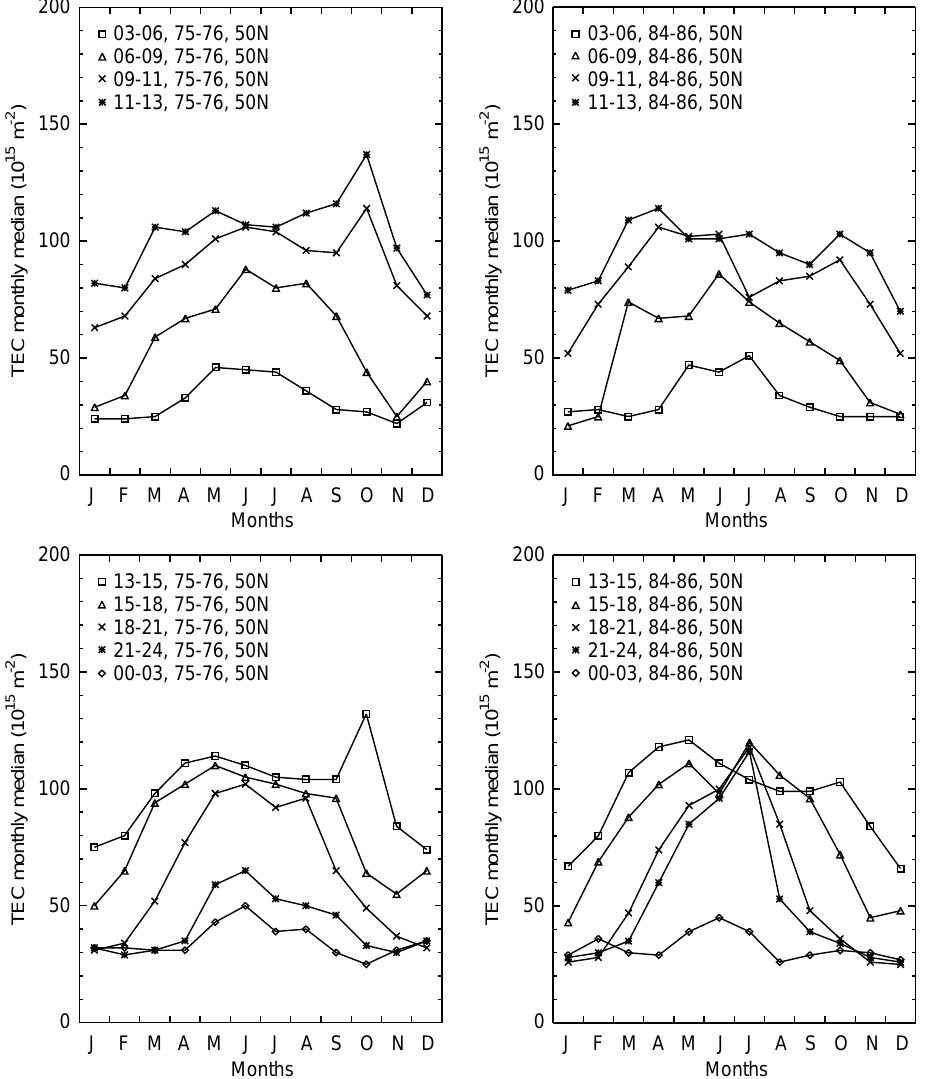
Fig. 1. Annual variation of monthly medians of ionospheric electron content for 50 (cid:14) N for intervals. LSA cycle 21 ( left ) and cycle 22 ( right ). From Feichter et al